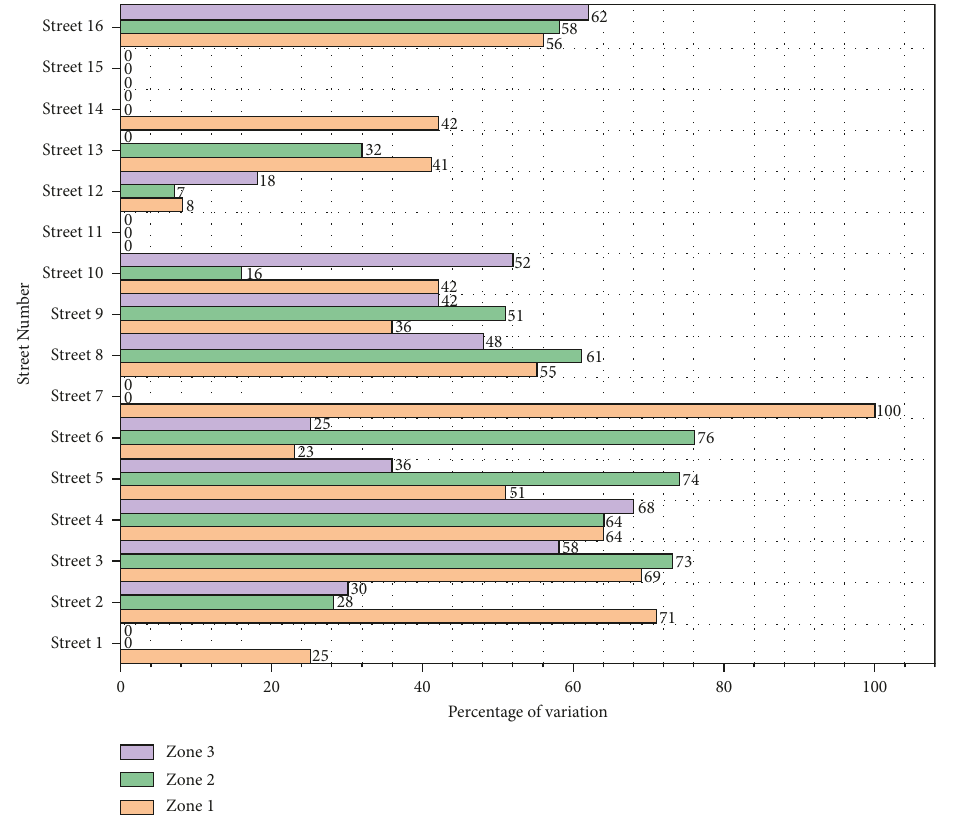
Figure 12: Percentage of variation between ESVI values for collapse type 1 at different seismic